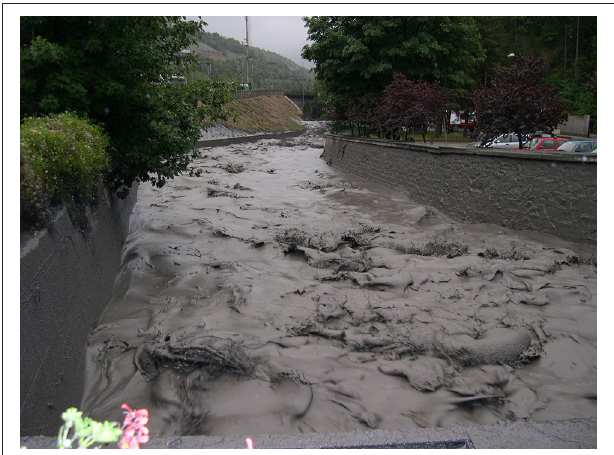
FIGURE 4 | An example of main type of torrential process that most frequently reaches the Rio Frejus’s alluvial fan area (6th August 2004).